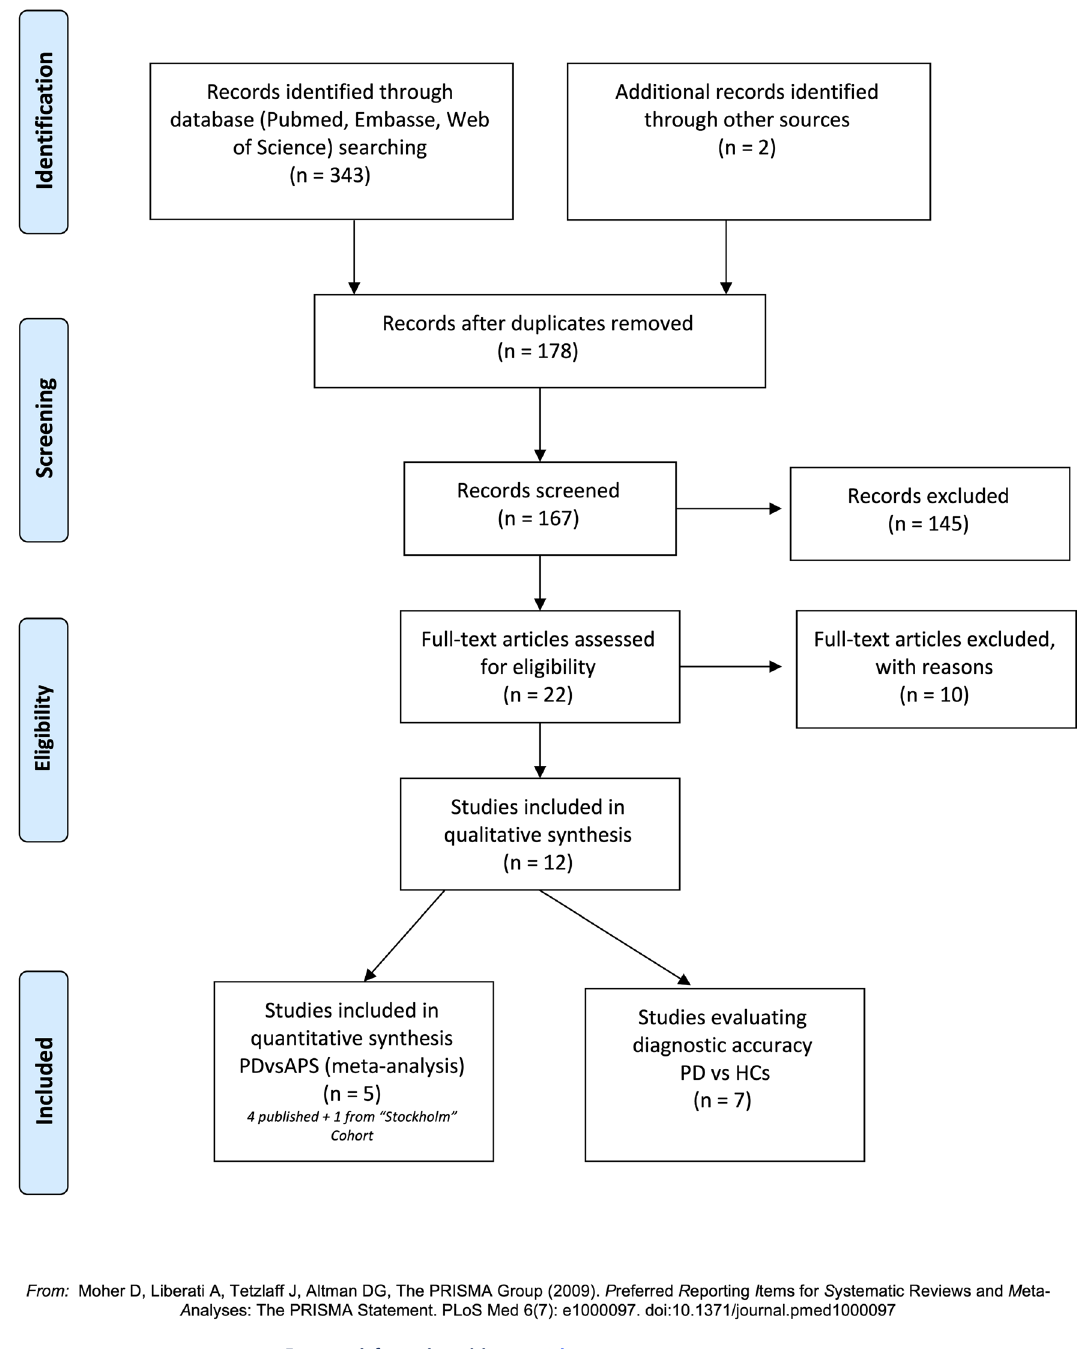
Figure 2. Flowchart of the successive steps of the systematic review